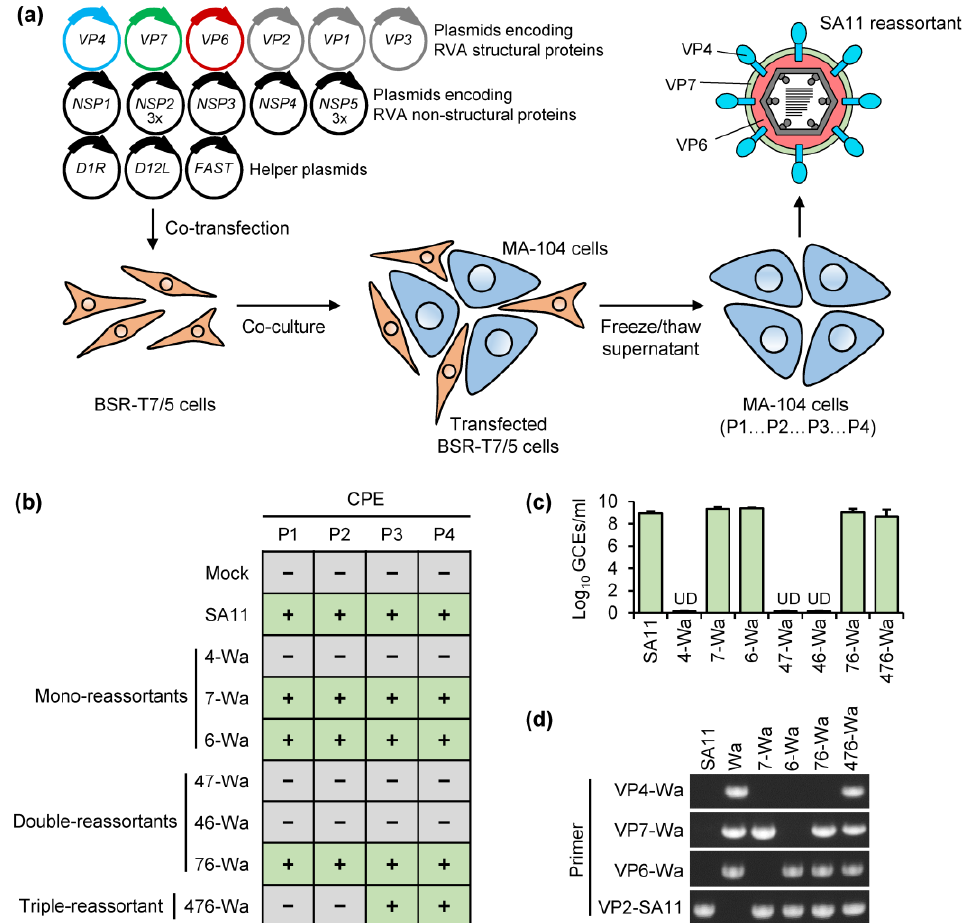
Figure 1. Generation of reassortants carrying VP4, VP7, and VP6 from human RVA strain Wa in the backbone of simian RVA strain SA11. ( a ) Scheme of the RG system used in this study. Eleven plasmids carrying the individual RVA genome segments under transcriptional control of the T7 RNA polymerase promoter as well as three helper plasmids for the constitutive expression of capping enzymes and a small cell fusion protein were co-transfected into BHK-21 cells that express T7 RNA polymerase (BSR-T7/5). Transfected cells were then co-cultured with MA-104 cells and trypsin in the absence of serum. Cell lysates were generated by freezing and thawing and used to infect fresh MA-104 cells. ( b ) Development of a rotavirus-typical cytopathic effect (CPE) upon passaging in MA-104 cells. The result is representative of two independent rescue experiments ( c ) Detection of RVA genomes via qRT-PCR in samples from passage 4 of MA-104 cells. The result is representative of two independent rescue experiments. ( d ) Detection of reassortant-specific genome segments via RT-PCR in samples from passage 4 of MA-104 cells. Abbreviations: 4 = VP4; 7 = VP7; 6 = VP6; CPE = cytopathic effect; P1 – P4 = passage 1 – 4; UD = undetected; GCE = genome copy equivalents.